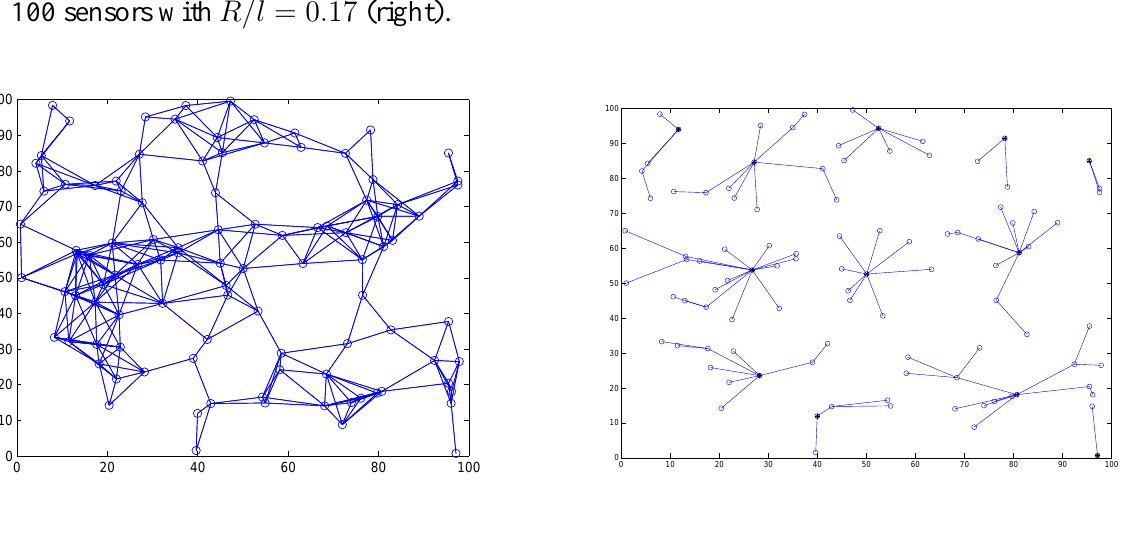
Figure 1. The connectivity of the network (left); clusters are formed in a random network of 100 sensors with R/l = 0 . 17